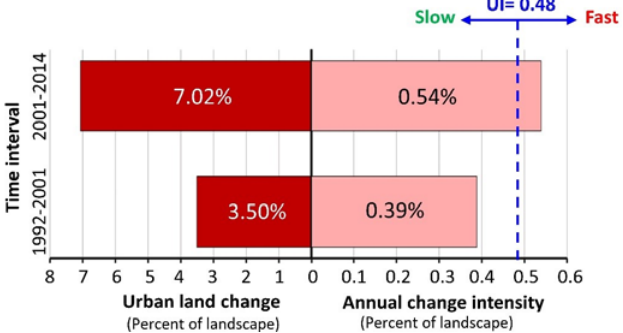
Figure 3. Intensity of ULCs in the CMA.